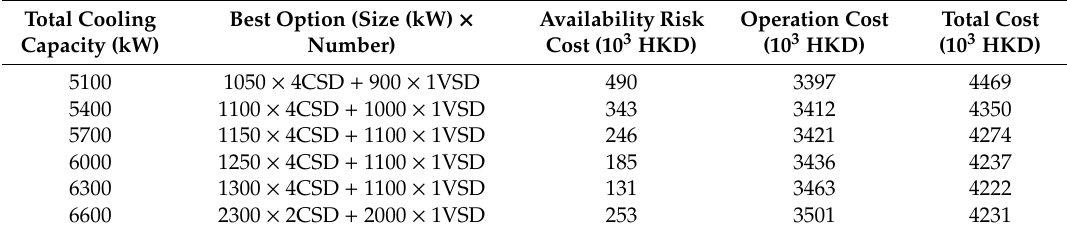
Table 7. Best design options under di ff erent total cooling capacities (penalty ratio: 10 HKD /